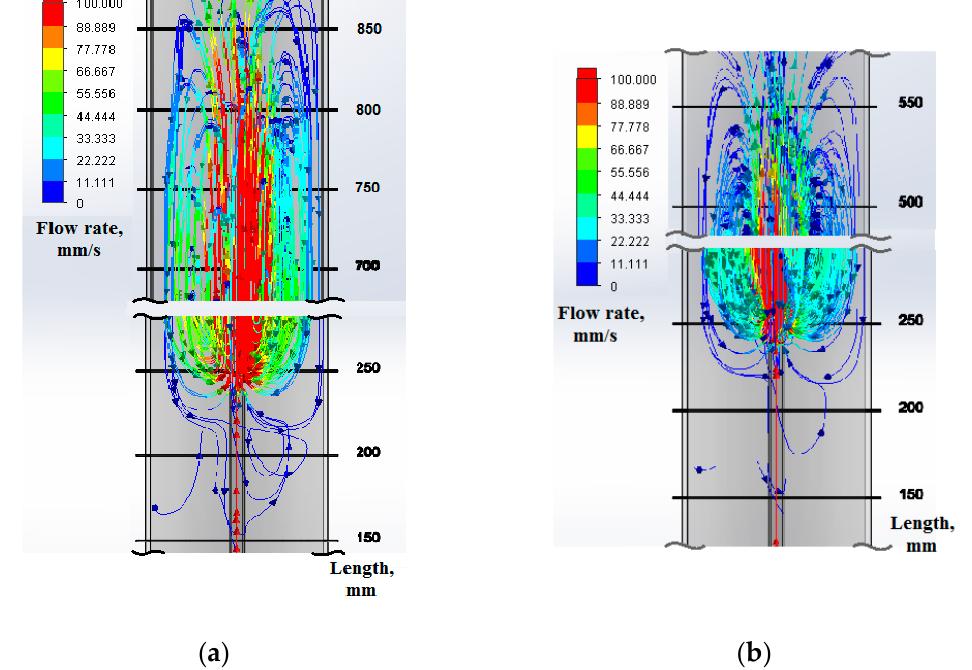
Figure 2. CFD simulation of the flow trajectory of a feed gas in the turbulence zone after exiting the FIT at two different feed gas flowrates: ( a ) hydrogen flowrate 2.8 L/min; ( b ) hydrogen flowrate 1.4 l/min.